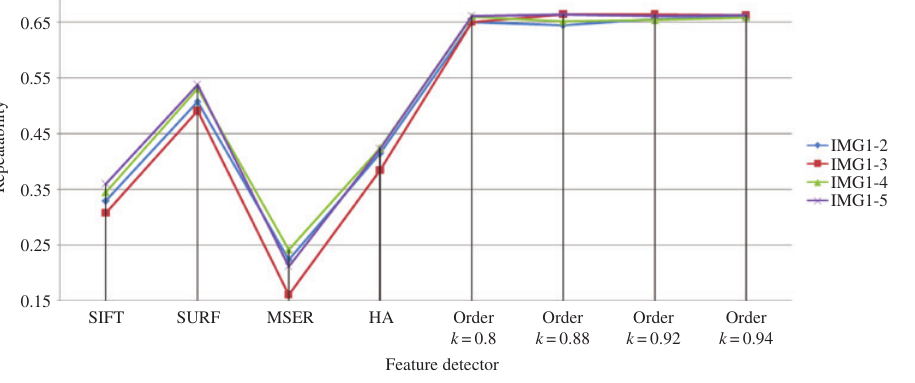
Figure 7: Repeatability Measure for Fractional Order k = 0.8, 0.88, 0.92, 0.94 is Compared Against Four Integer Order Feature Detectors Like SIFT, SURF, MSER, and Hessian Affine.